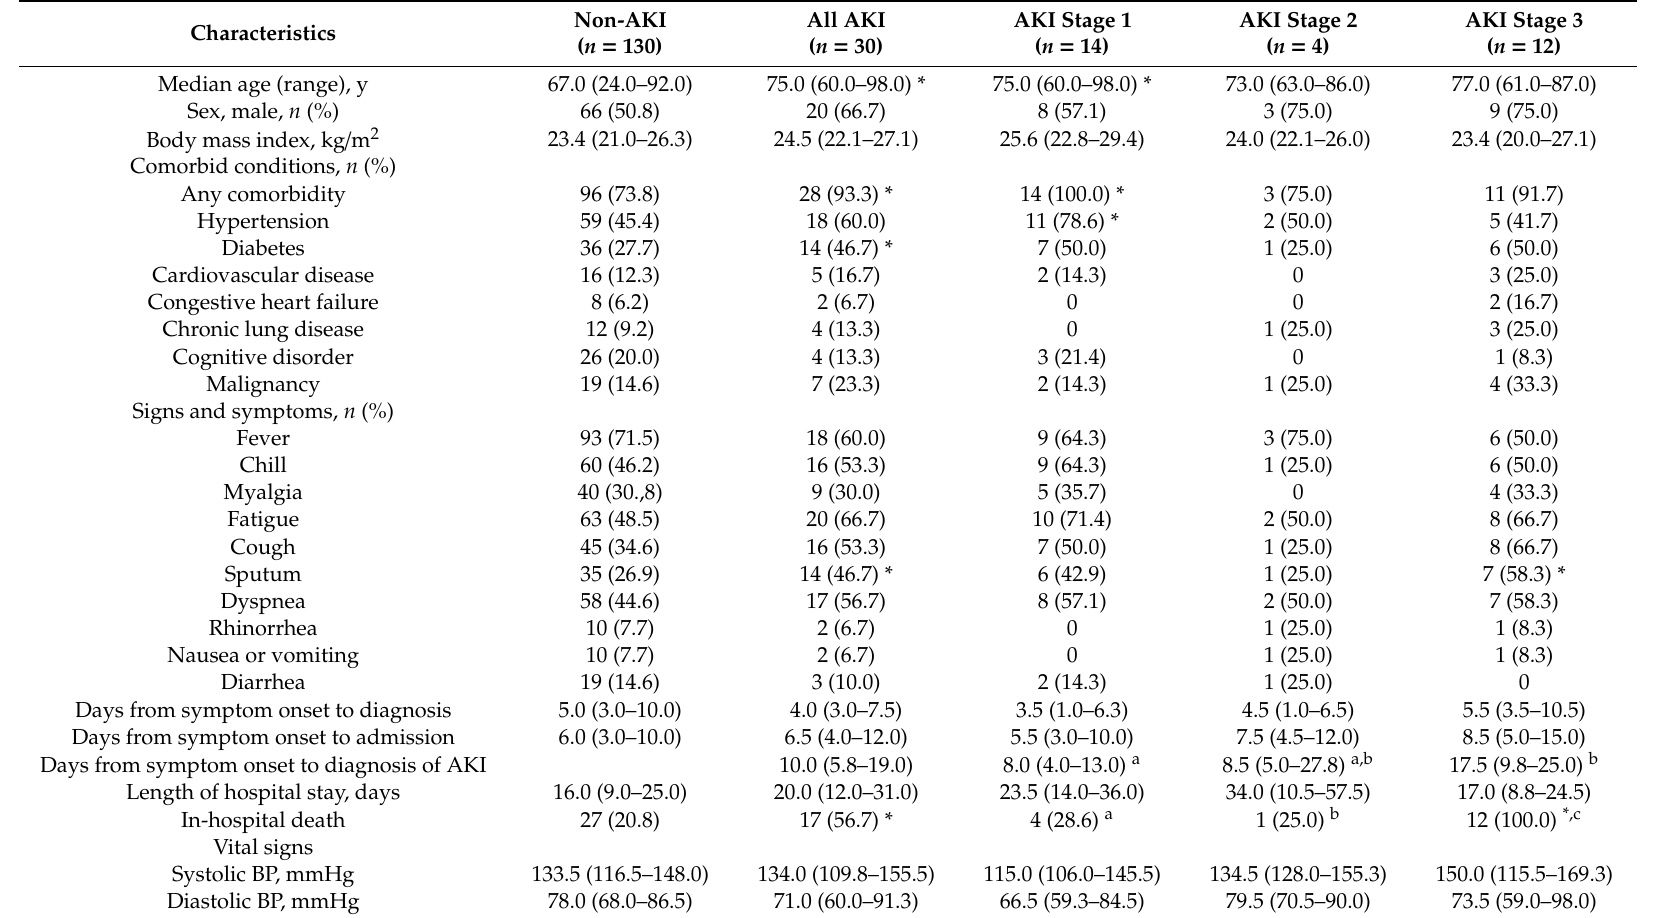
Table 1. Clinical